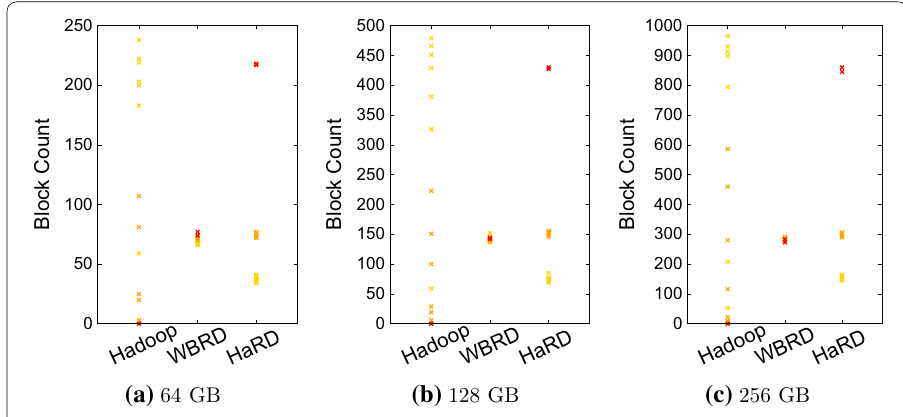
Fig. 4 Block distribution after the RF is decreased back to